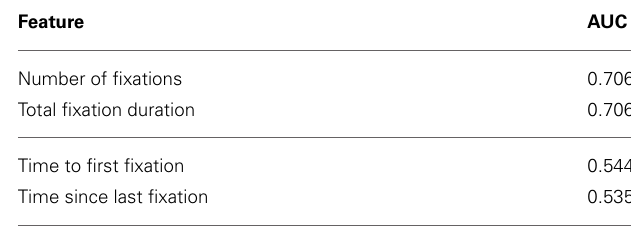
Table 2 | Mean proportions of fixated and named objects.